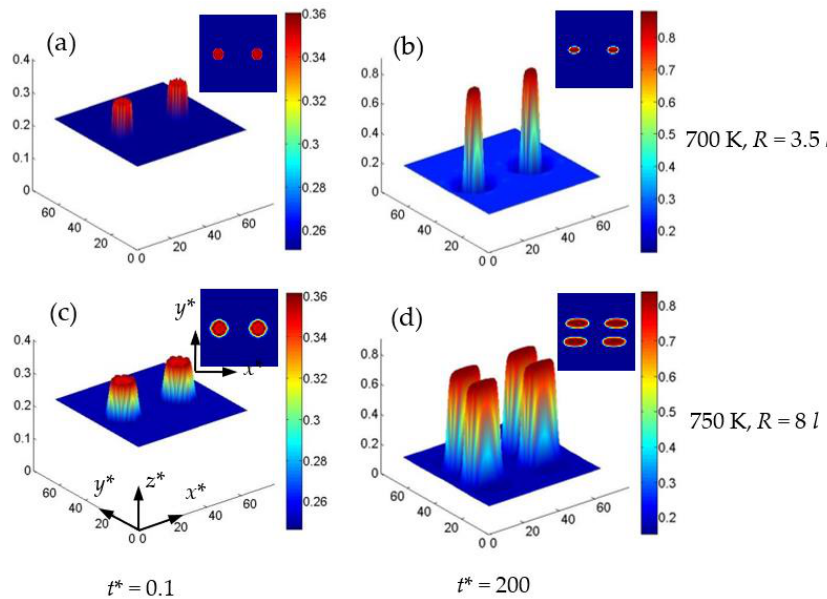
Figure 11. The concentration surface evolution of the Cr-enriched α′ phase from the initial circle regions with 35 at.% Cr under ε a xx = − 0.025 and c i R = 8 l